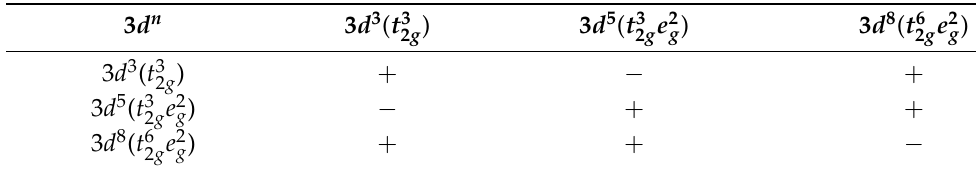
Table 2. Sign rules for the Dzyaloshinskii vector in pairs of the S-type 3d ions with local octahedral symmetry and the bonding angle θ > θ cr